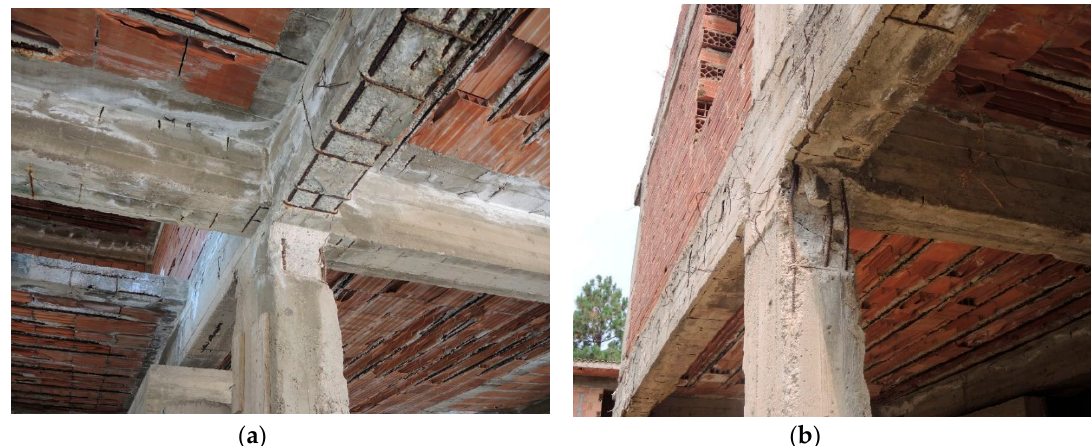
Figure 16. Run #9, 62.4 mm—1.69%: Concrete spalling, core crushing, and reinforcement buckling at the top of column c6 ( a ) and c13 ( b ).